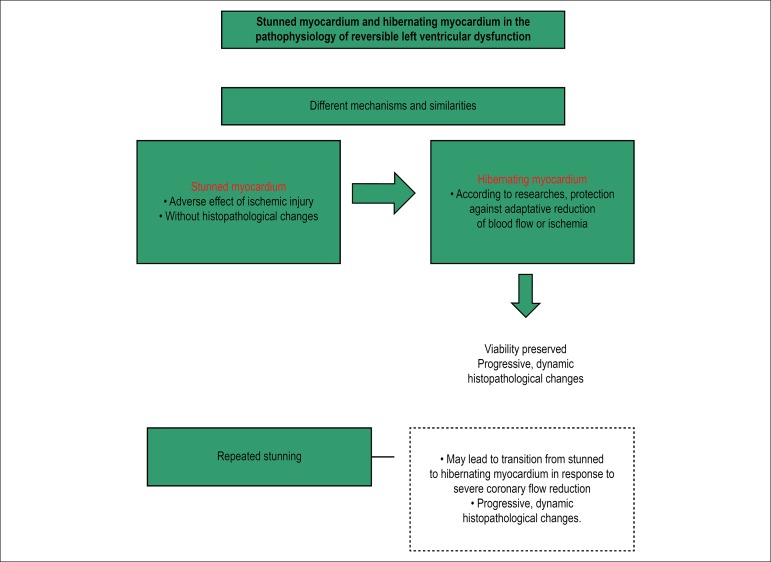
Main feature of the physiopathology of stunned myocardium and
hibernating myocardium [adapted from Chareonthaitawee et
al.8]